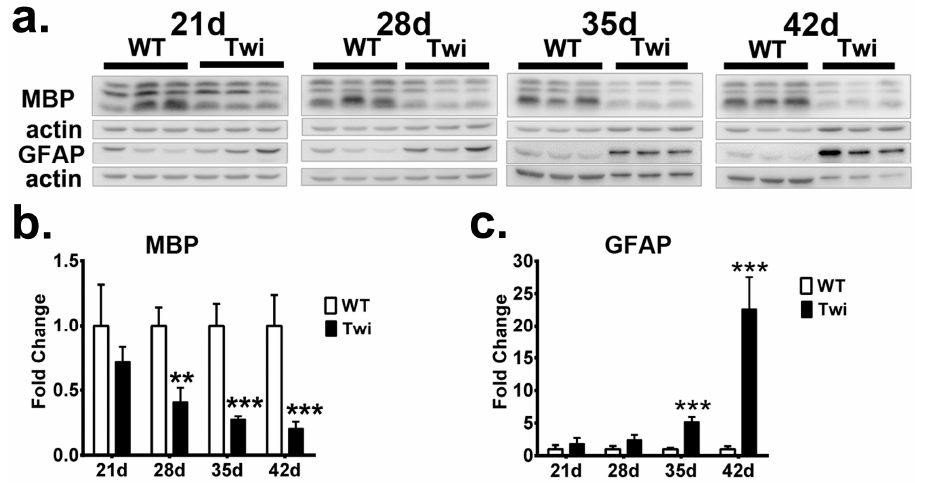
Figure 6. Progressive astrocytosis and demyelination in twitcher brain. ( a ) Western blot analysis of the total MBP and GFAP content in brain stems from wild-type (WT) and twitcher (Twi) mice at ages 21 days, 28 days, 35 days, and 42 days of age. b , c Quantification of MBP ( b ) and GFAP ( c ). β -actin (actin) was used for the loading control. Values are expressed as mean ± S.D. ( n = 3). Statistical significance, ** p < 0.01, *** p < 0.001.